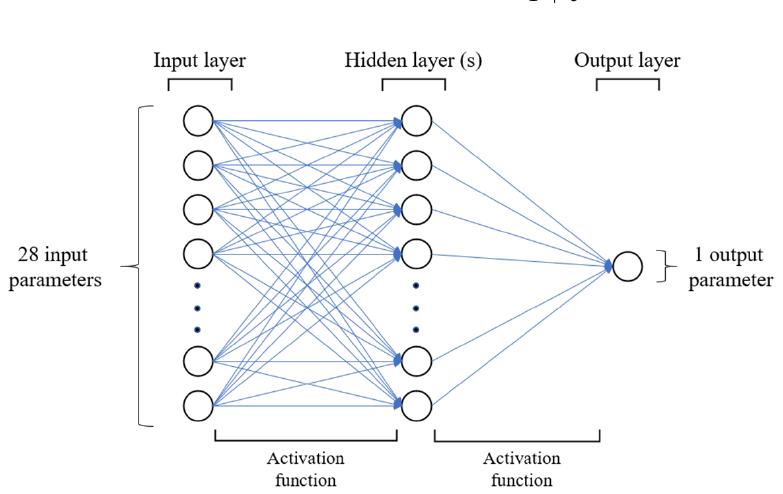
Figure 4. The artificial neural network structure for steam huff and puff injection proxy models used in this study. in this